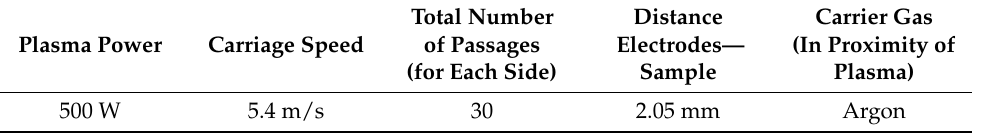
Table 1. Parameters for APP functionalisation.